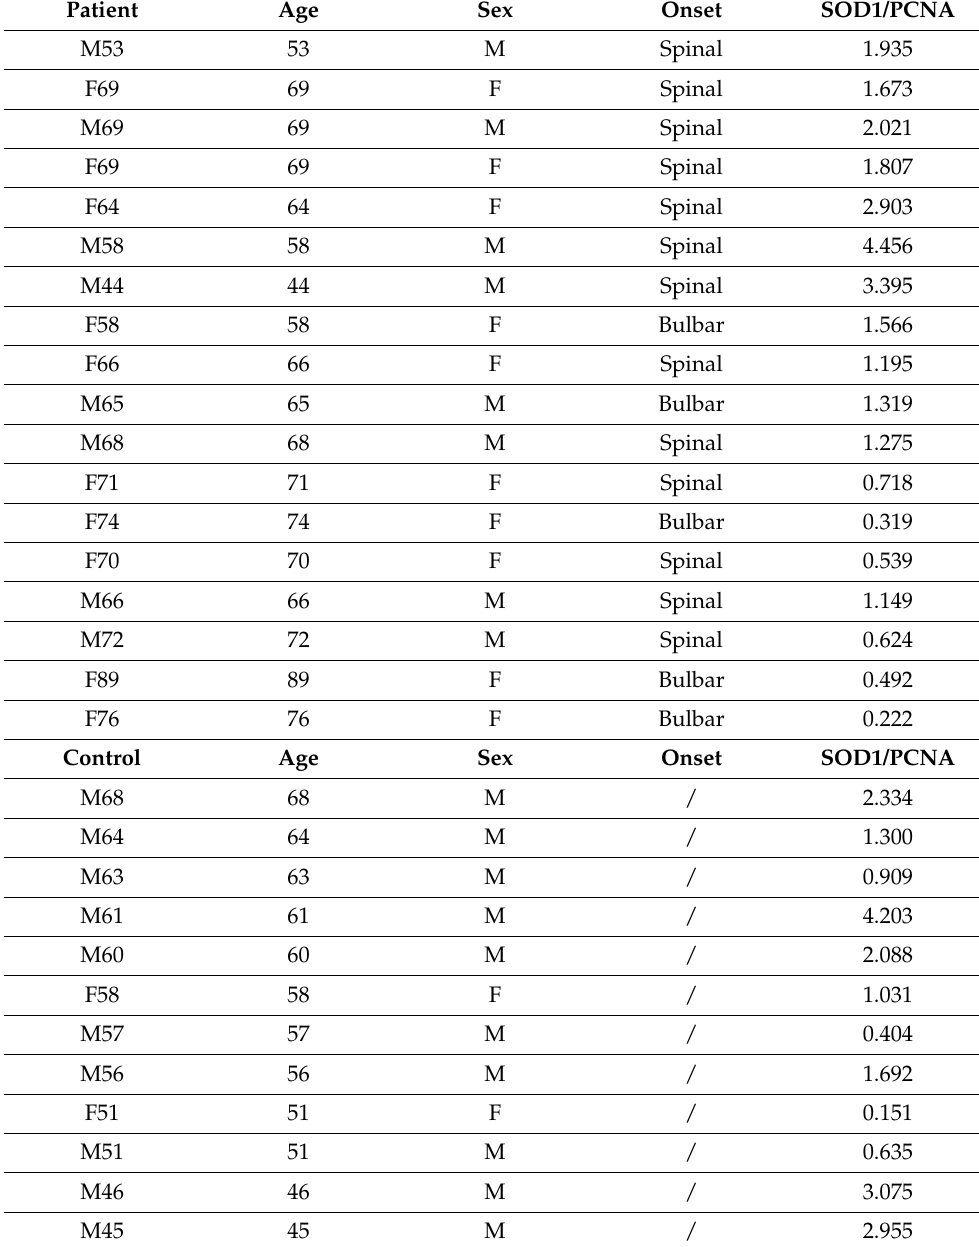
Table 1. Baseline characteristics of subjects recruited for this